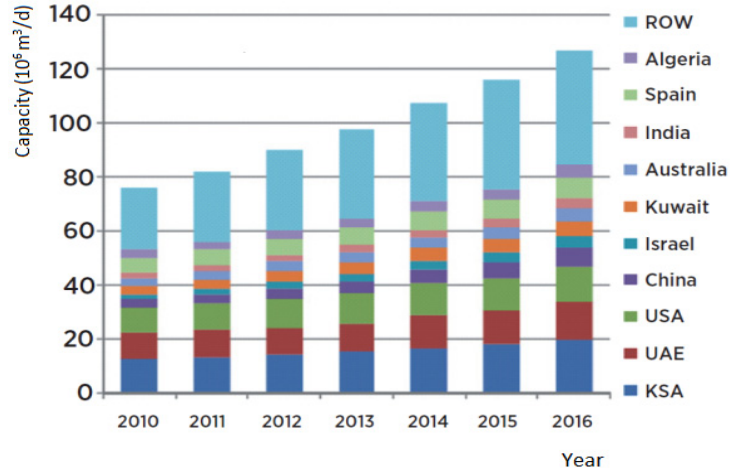
Figure 2. Global installed desalination capacity, 2010–2016. Adapted from